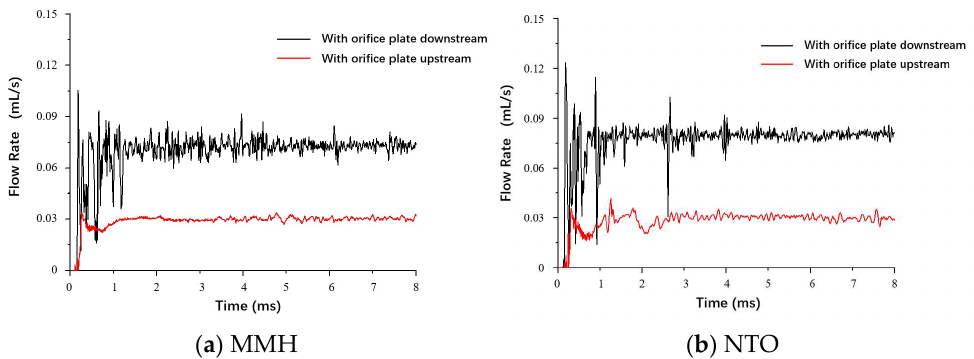
Figure 13. Comparison of MMH ( a ) and NTO ( b ) flowrate fluctuation under different switch speeds, with downstream orifice plate and 0.15 mm stroke.